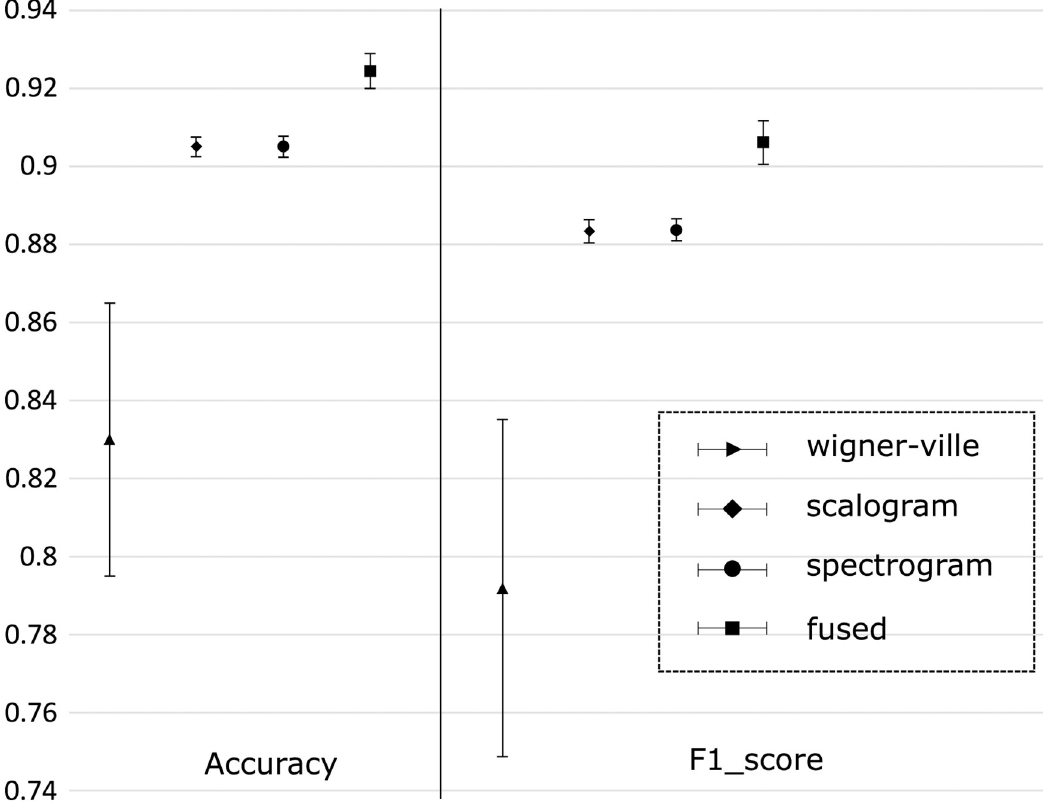
Fig 11. Overall 10-fold cross-validation results for per-segment apnea detection with Wigner–Ville distribution, scalogram, spectrogram, and fused images. Black lines indicate the corresponding 95% confidence interval.